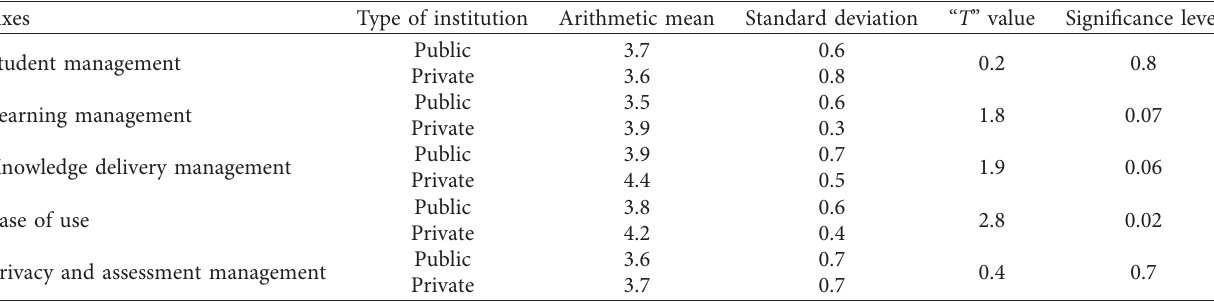
Table 11: Results of the t -test for the quality measure of e-learning programs for faculty members for the institution type variable. Axes